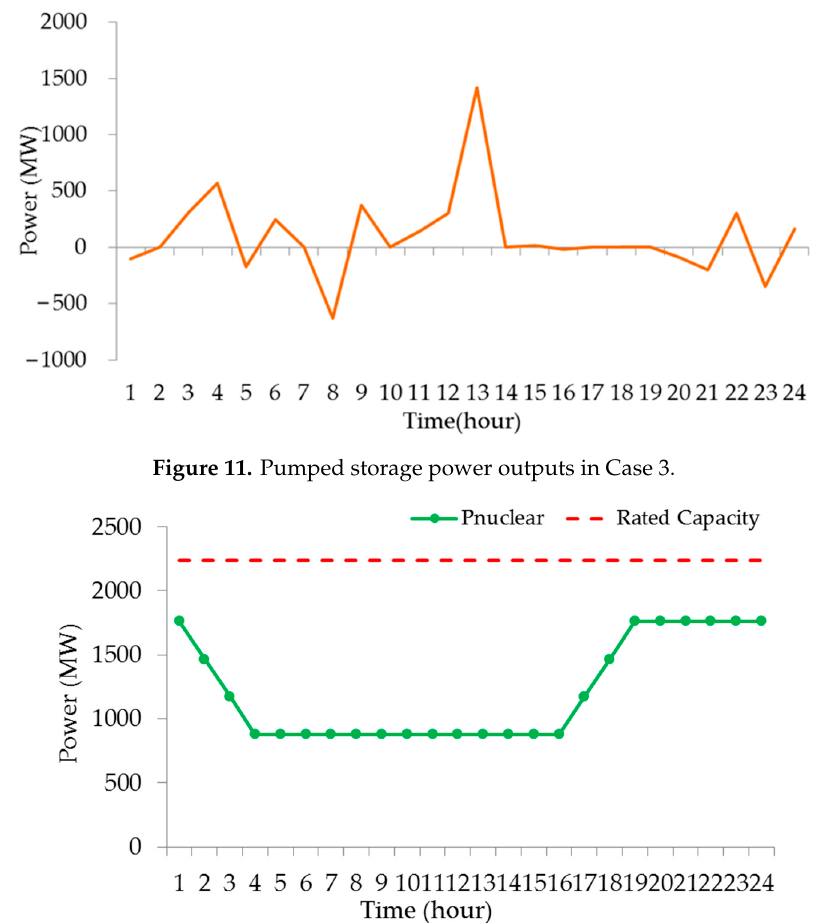
Figure 10. Thermal power outputs in Case 3.